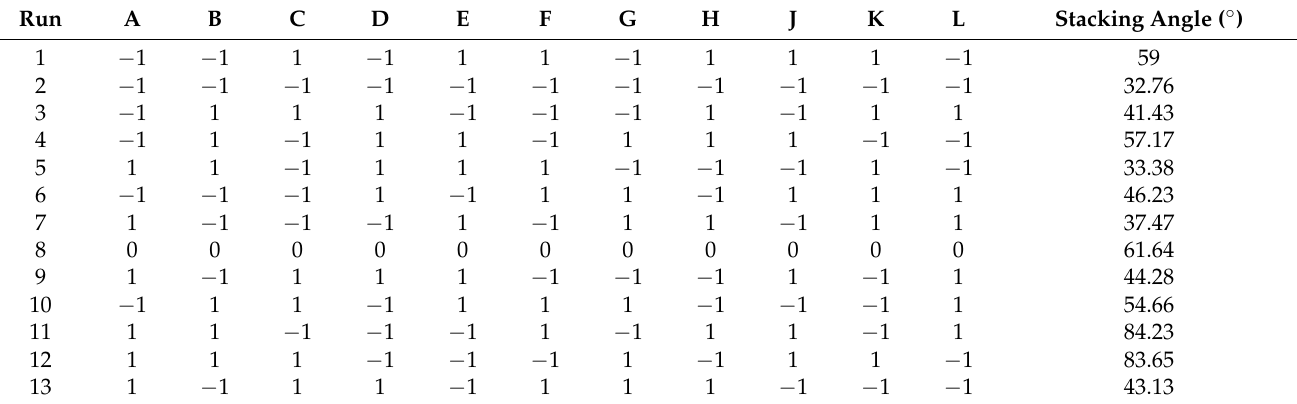
Table 2. The protocol and results of PB test.